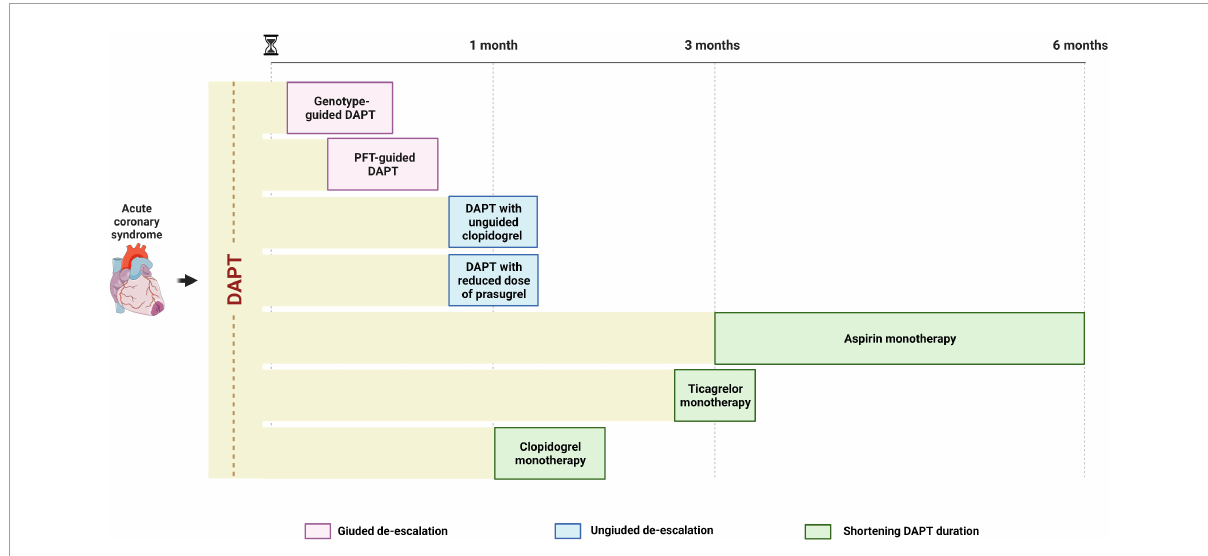
FIGURE3 Timing for de-escalating antiplatelet therapy after ACS undergoing PCI. A guided de-escalation strategy allows for an early (days or weeks) de-escalation of antiplatelet therapy while unguided de-escalation is to be performed at least 1 month after ACS and shortening of DAPT is to be performed 1–6 months after ACS, depending on modality (aspirin or P2Y 12 inhibitor monotherapy). ACS, acute coronary syndrome; DAPT, dual antiplatelet therapy; PCI, percutaneous coronary